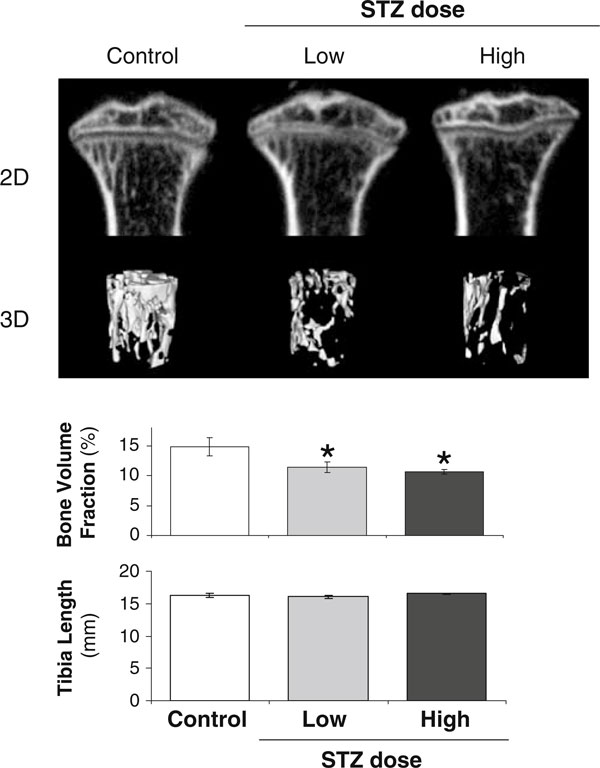
Bone loss is evident in diabetes induced by both low- and high-dose STZ. The two-dimensional images at the top were obtained from micro-computed tomography analyses of representative tibias from control and STZ-treated mice (40 days post first injection). Three dimensional images were composed of 760 consecutive slices. The bar graphs indicate the measured bone volume fraction (average ± SE) of the tibial trabecular region and the tibia lengths of control (white bar), 40 mg/kg STZ (low dose, gray bar), or 60 mg/kg STZ mice (high dose, black bar). n > 3 per condition. *p < 0.05 compared to control.